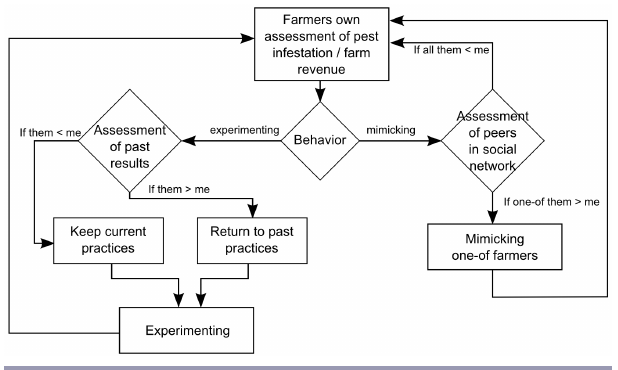
farm revenue; a comparison with his or her personal or peers’ management